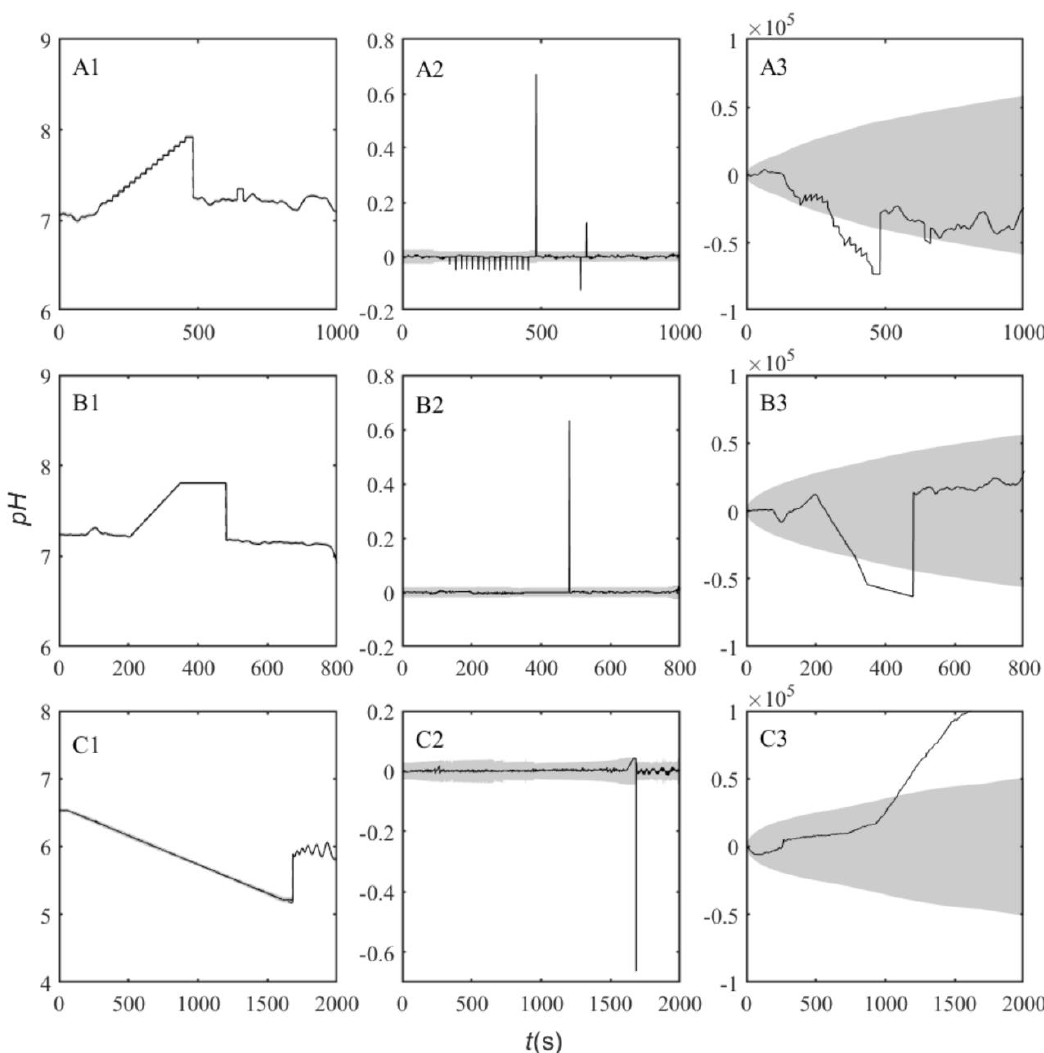
Figure 9. Anomaly detection results of AIT202 (α = 6, φ = 6). Title represents: ( A1 – A3 ) = dataset 2, ( B1 – B3 ) = dataset 3, ( C1 – C3 ) = dataset 4, 1 = observations and predictions, 2 = errors between predictions and observations and 3 = accumulated errors. Dashed - dotted line = observations, solid line = predictions.